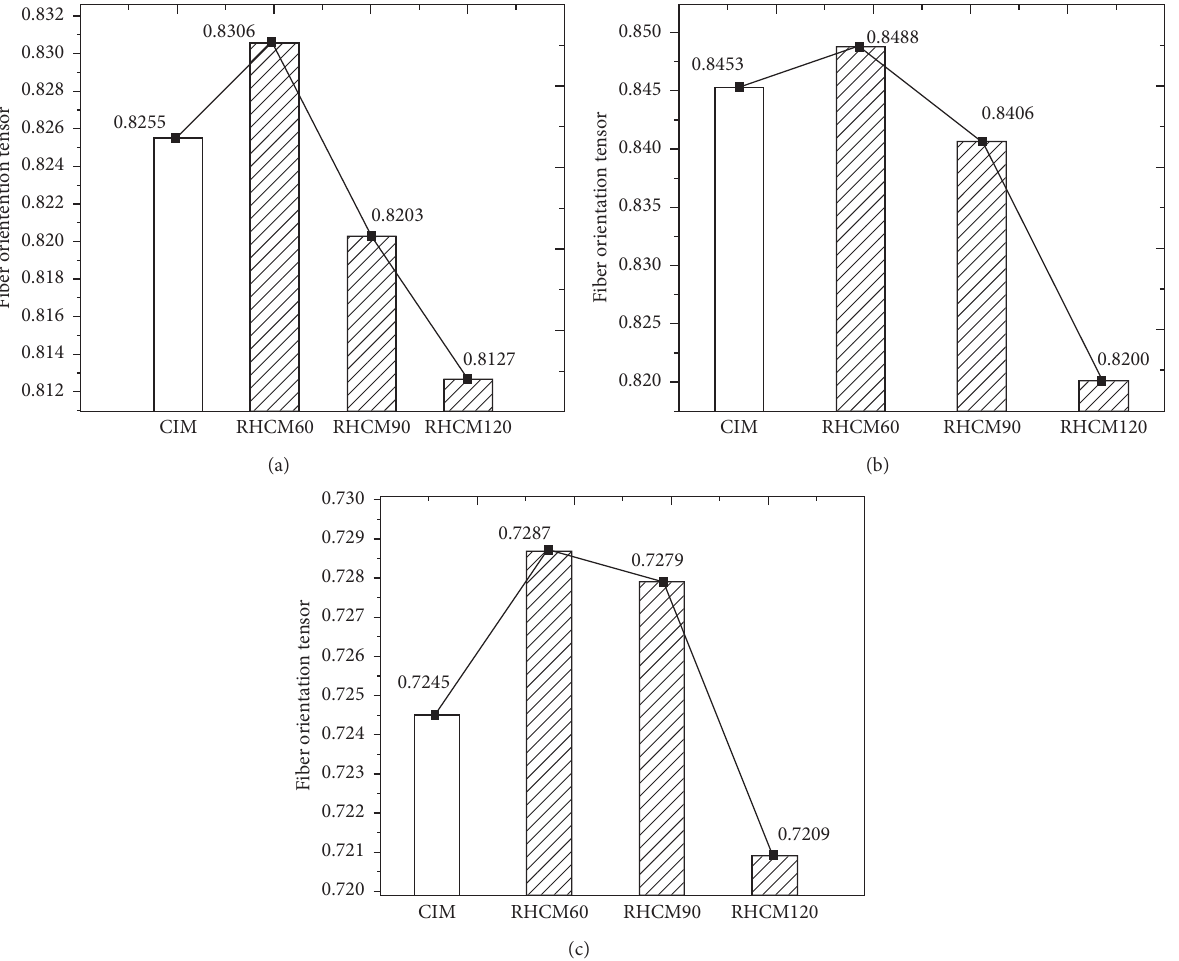
Figure 7: Schematic of layer fiber orientation tensor change trend in RHCM and CIM samples: (a) within skin layer; (b) within shear layer; (c) within core layer.